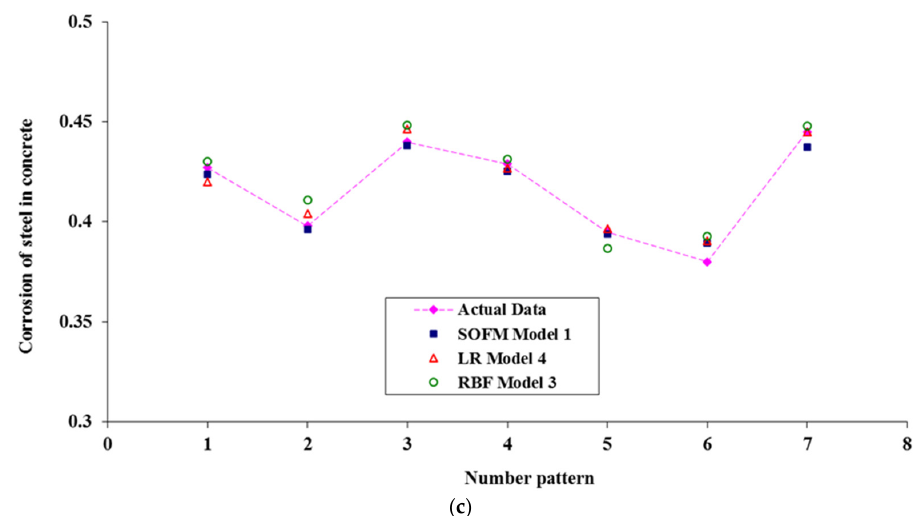
Figure 8. Comparison of corrosion current density prediction using the different SOFM models in the processes of ( a ) training, ( b ) validation, and ( c ) testing.